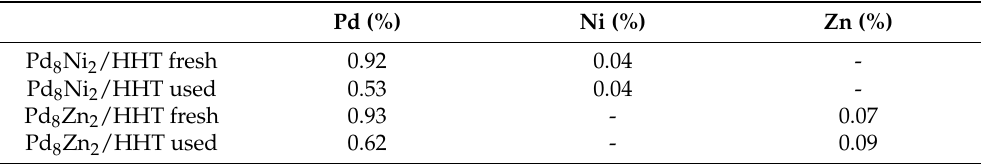
Table 6. Results of inductively coupled plasma optical emission spectroscopy (ICP-OES) analyses on fresh and used catalysts. The percentages of metals are related to the total amount of solid catalyst.